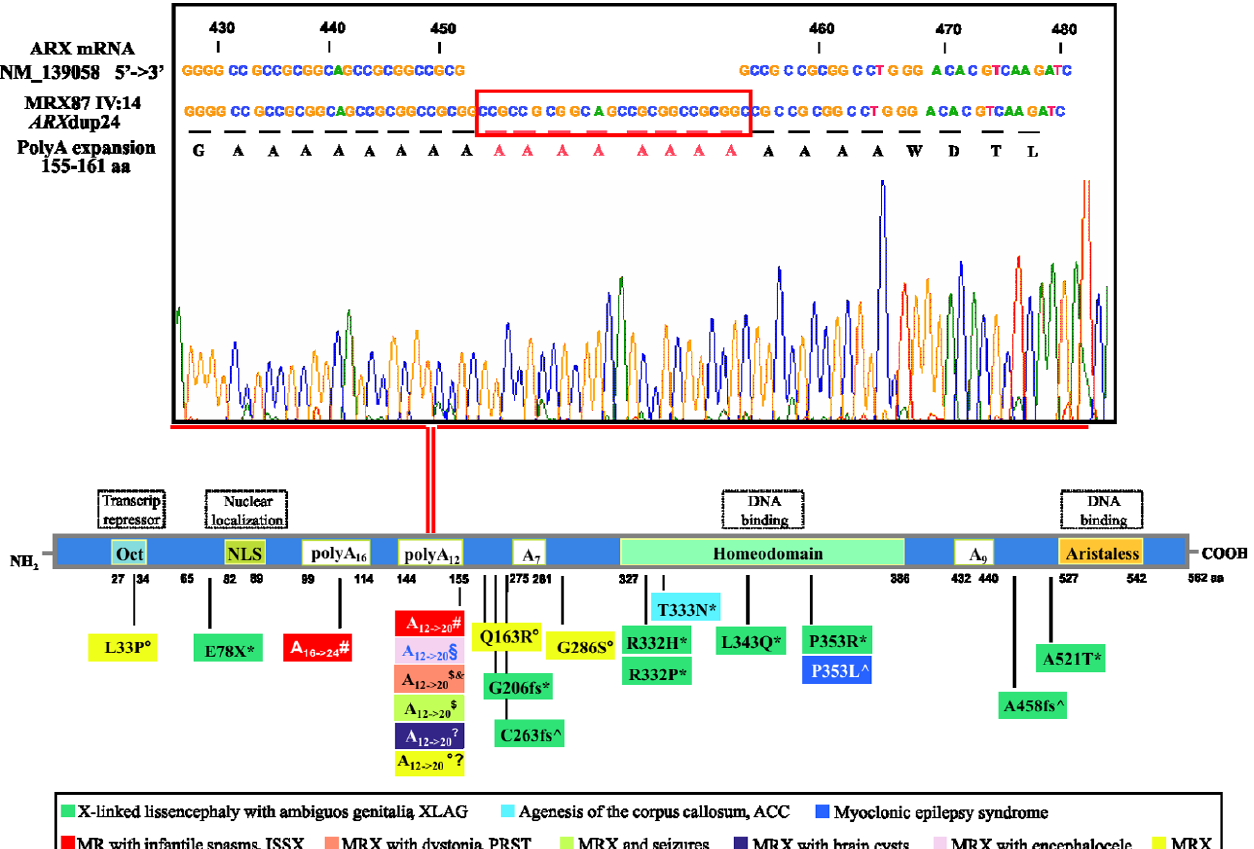
Figure 3 At the top of the figure: Electropherogram of amplicon b of the ARX exon 2 in MRX87 IV:14. The box indicates the nucleotide sequence duplicated in the ARX gene (c.428_451dup24 also known as ARX dup24). At the bottom of the figure: ARX protein functional domains and polyA tracts are shown, next to the various mutations that results in a spectrum of